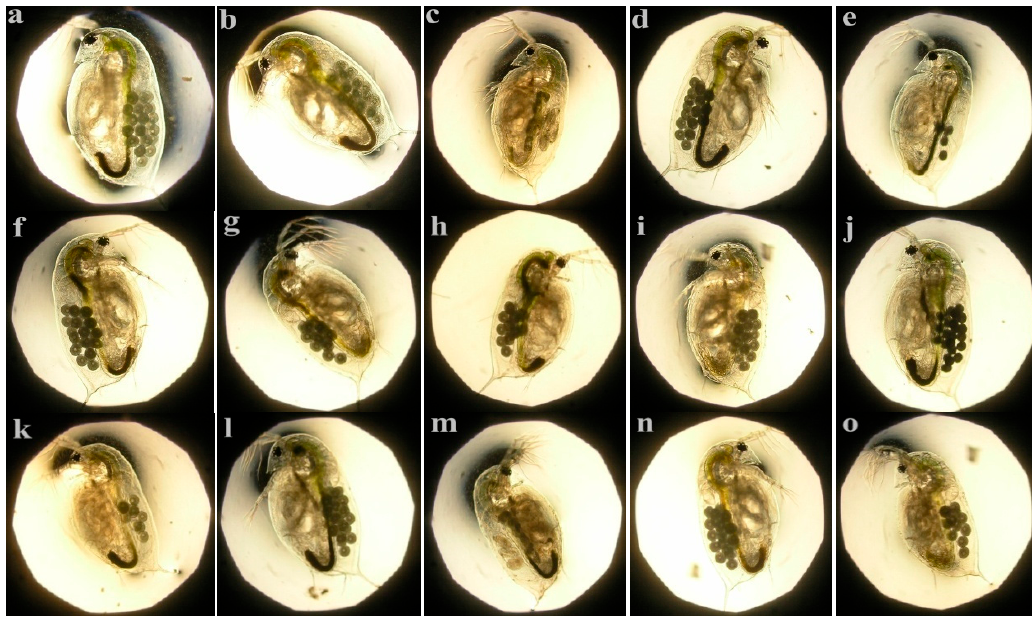
Figure 3. Microphotograph of offspring (9-d old) of D. magna a represents the control group; b , d , f , h , j , l , and n represent the treatment groups of DWTR, SNR-10, SR1-10, SR5-10, SNR-180, SR1-180, and SR5-180 at concentration of 5000 mg L − 1 ; c , e , g , I , k , m , and o represent the treatment groups of DWTR, SNR-10, SR1-10, SR5-10, SNR-180, SR1-180, and SR5-180 at concentration of 500 mg L − 1